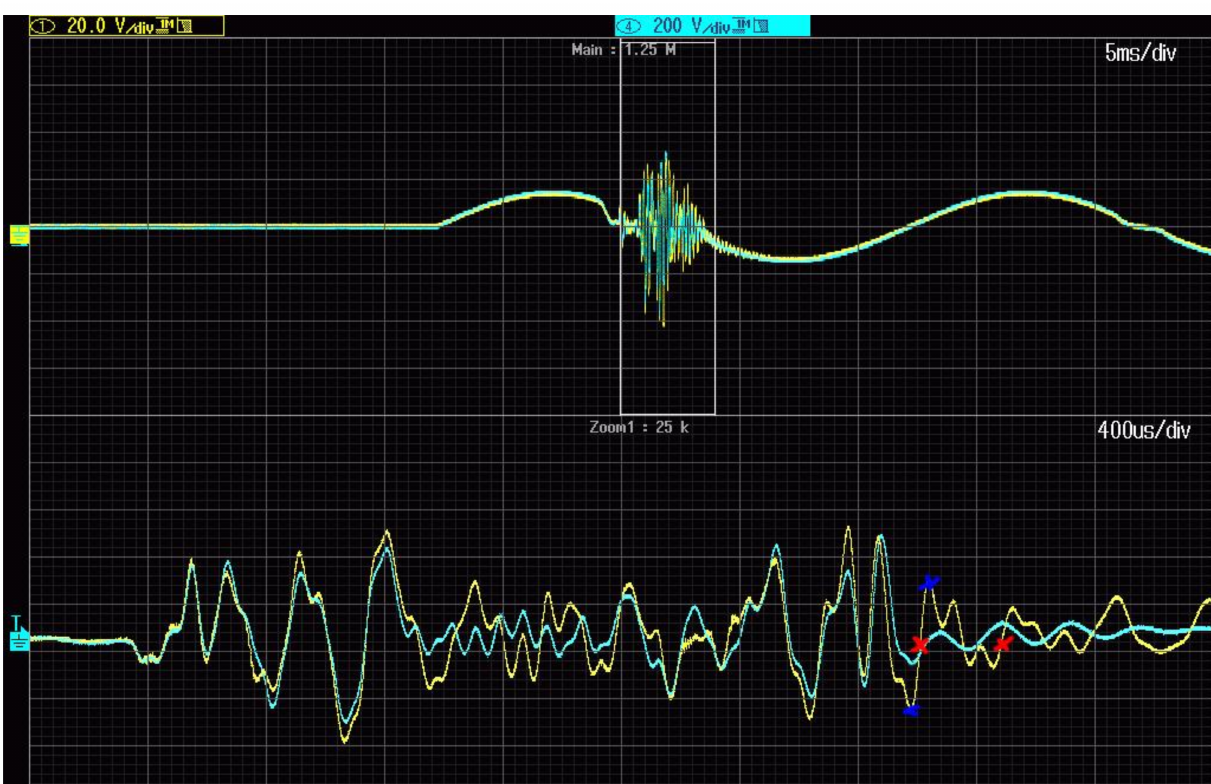
Figure 7. Voltage waveforms of voltages on primary (blue line) and secondary (yellow line) windings of the 20 kV inductive VT (model